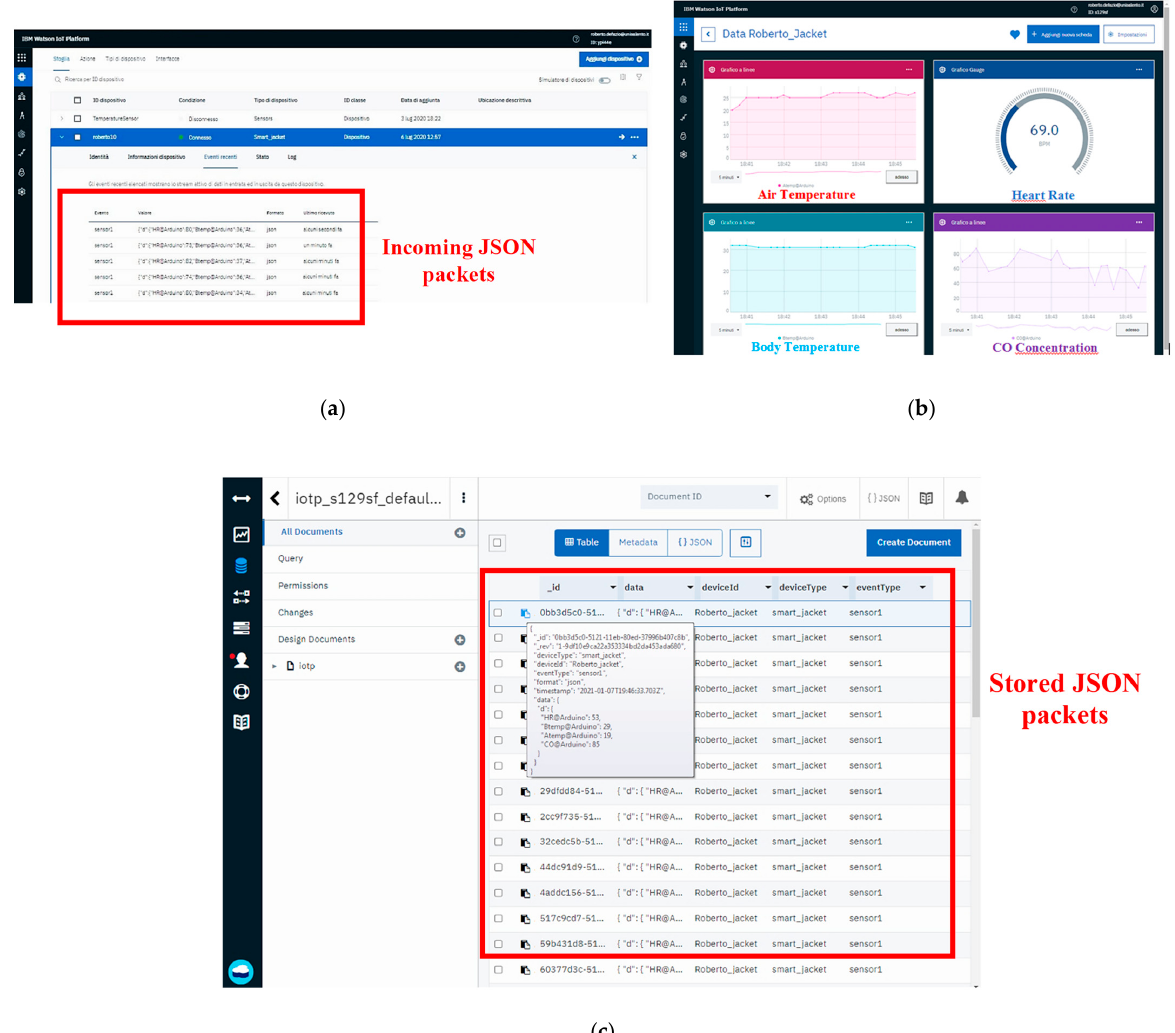
Figure 20. Views of the IBM Cloud platform: event section of the IBM Watson IoT cloud platform, where the incoming JSON packets are displayed ( a ); dashboard used to visualize the data received by the wearable device ( b ); dashboard of the IBM Cloudant database with the stored packet transmitted by the wearable device ( c ).